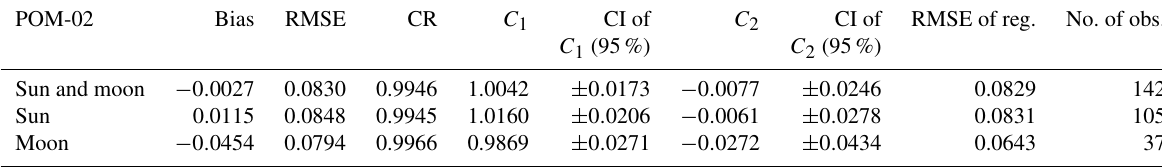
Table 7. Same as Table 4 except for GPS and radiosonde precipitable water vapor. Sonde Bias RMSE CR C 1 CI of C 1 (95%) C 2 CI of C 2 (95%) RMSE of reg. No. of obs. Sonde 0.0770 0.2229 0.9791 0.9425 ± 0 . 0233 0.1572 ± 0 . 0403 0.2007